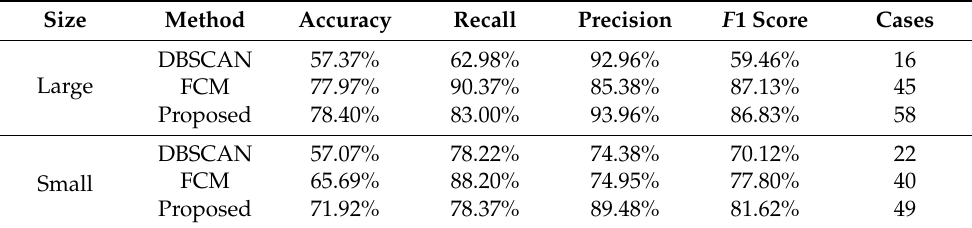
Table 3. Performance result with respect to the size of the ganglion cyst. Colored, statistically significant ( p <